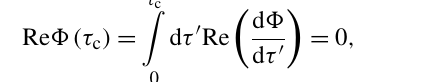
value r c = r 0 + (cid:15)t c determined by relation